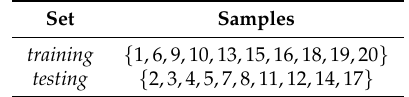
Table A2. Training and testing sets for the numerical